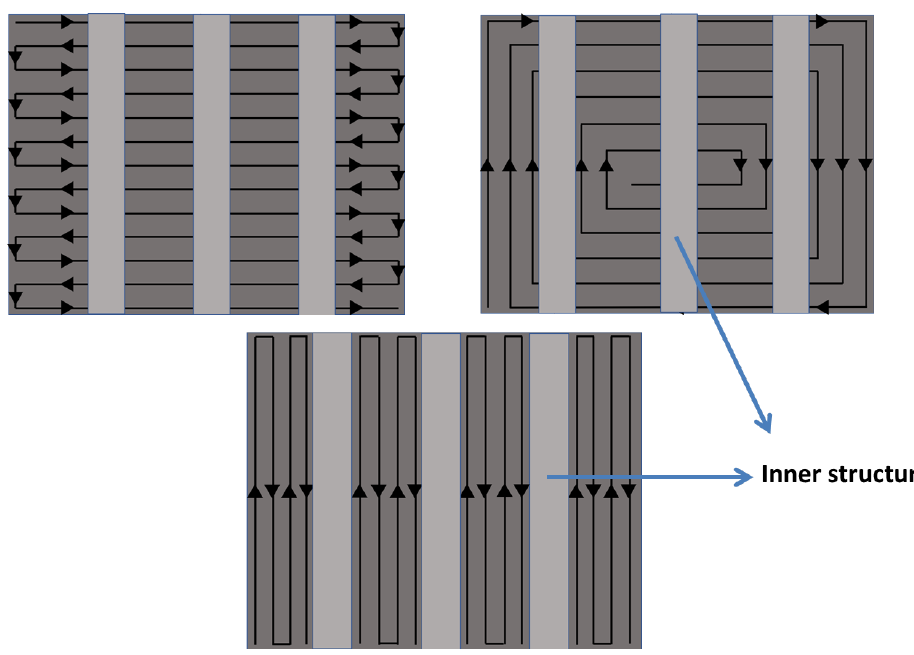
Figure 7. Specific scan strategies shown on the specimens with the inner structure.